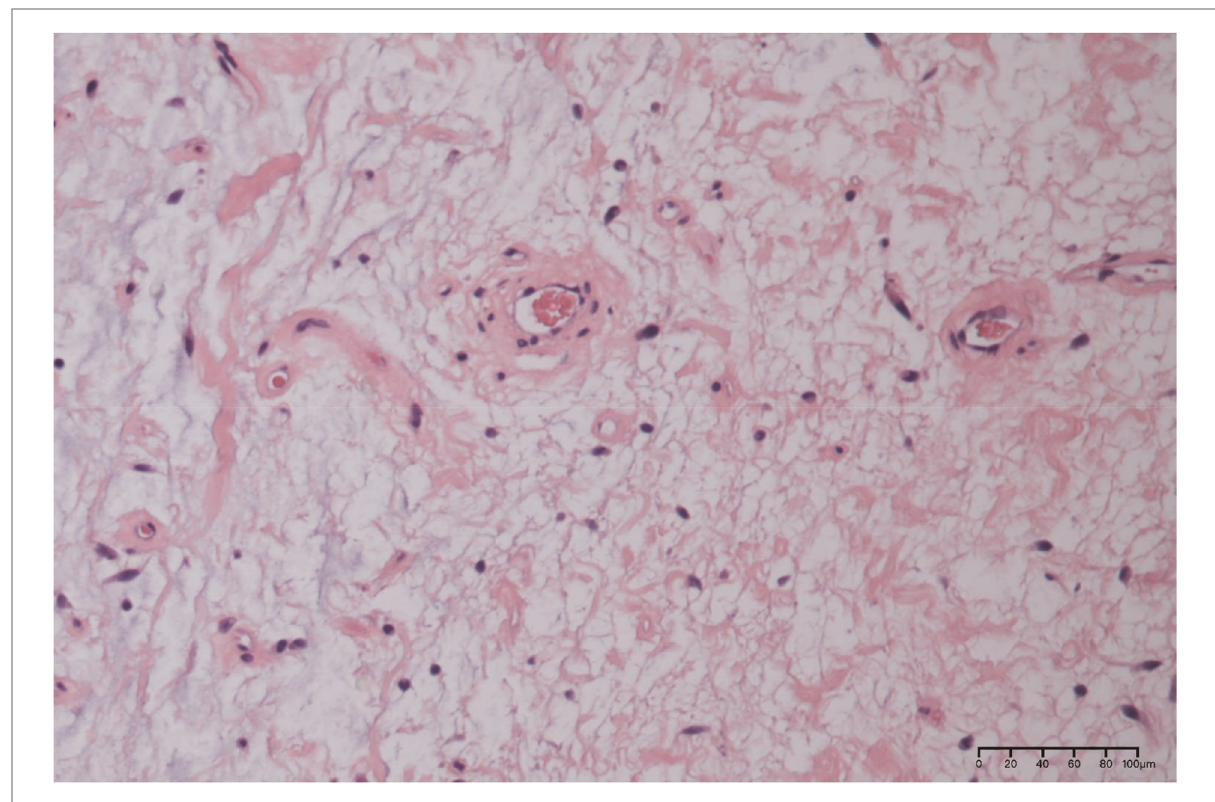
FIGURE 3 Pathological histological section of this case (HE×200). Scattered spindle cells, stellate cells and perivascular in fl ammatory cells are visible against the background of a large amount of mucus stroma